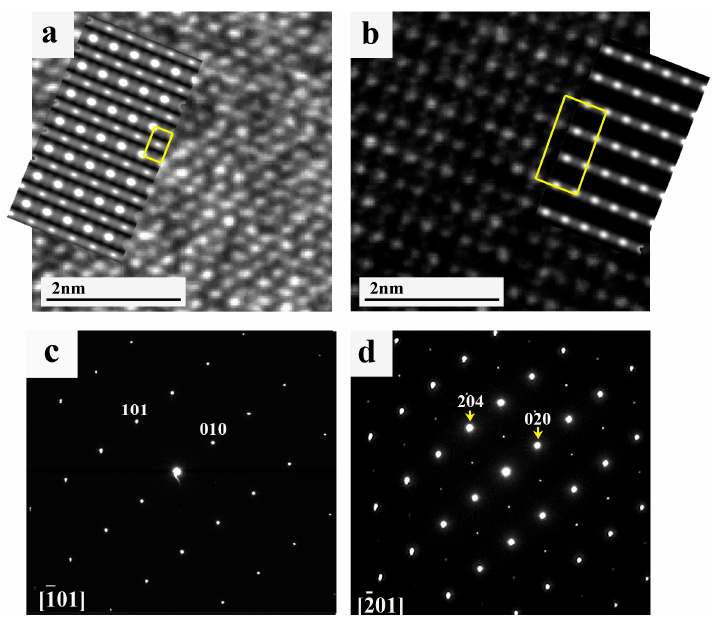
Figure 5. HRTEM images taken from the ( a ) disordered cubic and ( b ) ordered tetragonal U(Al, Si) 3 phases at [ 101 ] and [ 201 ] orientations, respectively. Simulated images (shown in the insets) were prepared in JEMS [17] on the basis of the model presented in [9,10]. For clarity, the 2D unit cell is shown. ( c , d ) present corresponding electron diffraction patterns taken from these phases (i.e., disordered and ordered, respectively) at the same orientations.